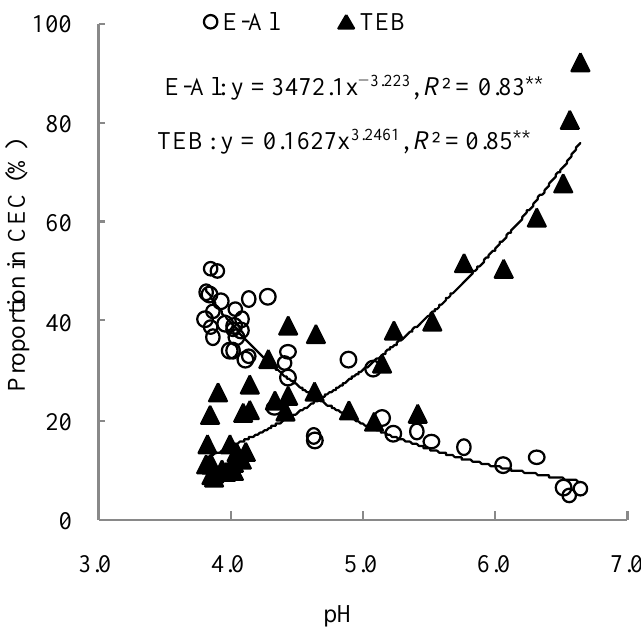
Figure 4. The ratio of TEB and E-Al in CEC changes with soil pH. Note: ** represents significance at 0.01 probability level.